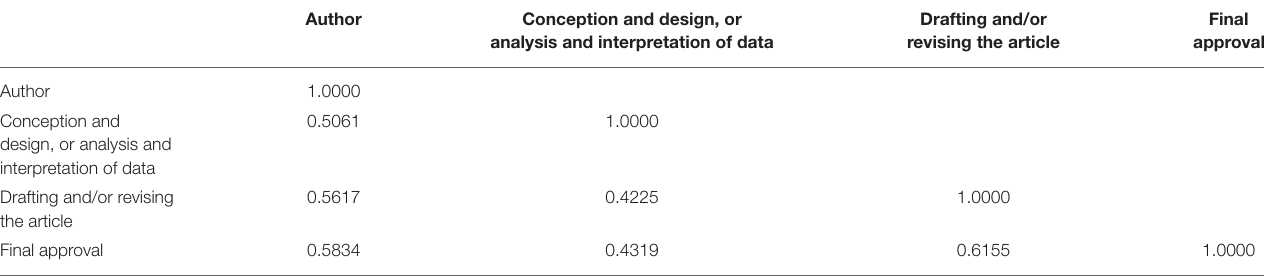
TABLE 3 | Correlation matrix of vancouver criteria.